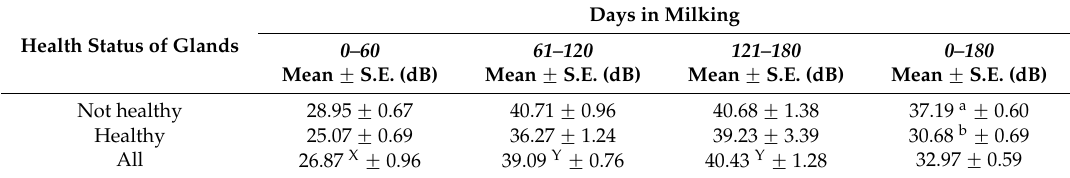
Table 11. Overall means and standard errors (S.E.) of the amplitude of the first most representative spectrum peak (FFT_P 1 ), according to mammary gland health status and lactation stages.